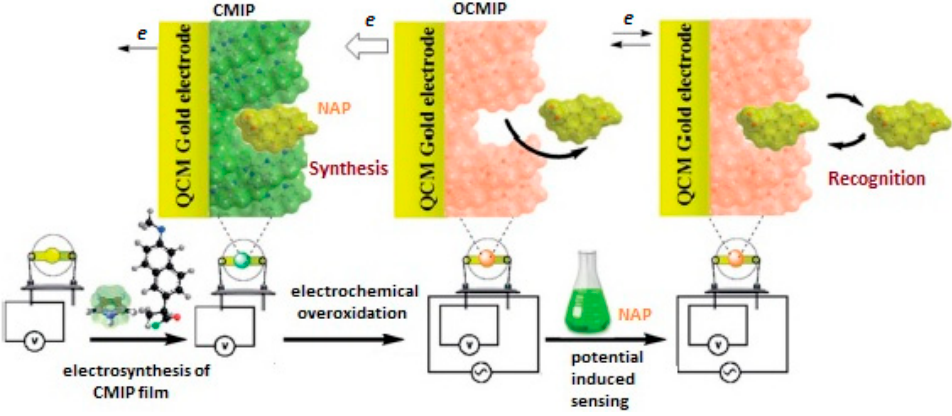
Figure 10. MIP-based QCM sensor for naproxen (reproduced with permission from [64]).